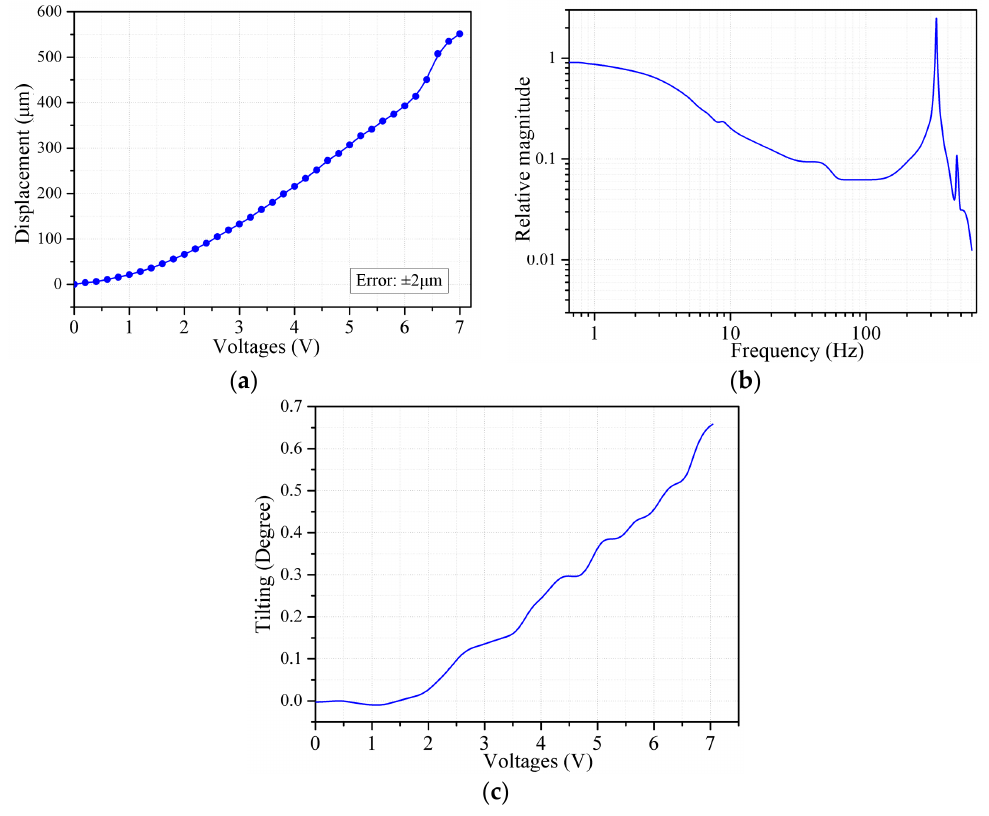
Figure 5. ( a ) Quasi-static response curve; ( b ) Frequency response curve; ( c ) The tilt angle versus voltage.